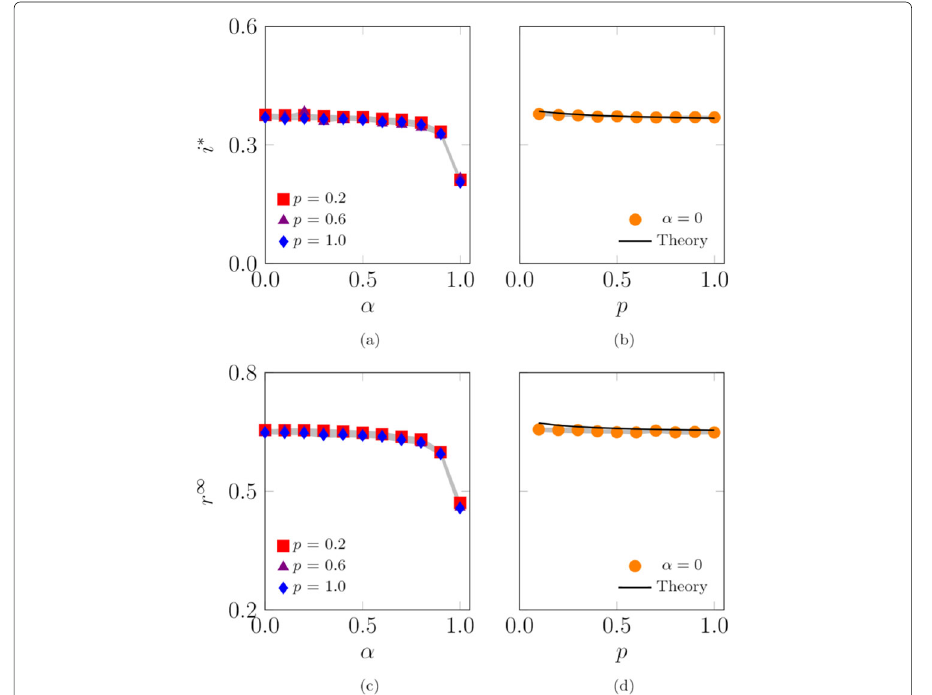
Fig. 7 Influence of the agents’ randomness, α , and probability of jumping outside the location, p , on the SIS endemic prevalence, a - b , and SIR epidemic size, c - d . Theoretical values of the SIS endemic prevalence, b , and SIR epidemic size, d , are computed by evaluating the steady state in Eqs. (13) and (16), respectively. Curves represent the median of 100 independent simulations; 95% confidence bands are displayed in gray. Agents are initially inside their base location and the infection starts after 100 steps to allow the agents to reach a steady-state configuration. The fraction of randomly chosen initial infected is 0.01. Other parameter values are L = 100, N = 10,000, D = 100,000, r = 0.01, c = 0.3333, λ = 0.05, and μ =